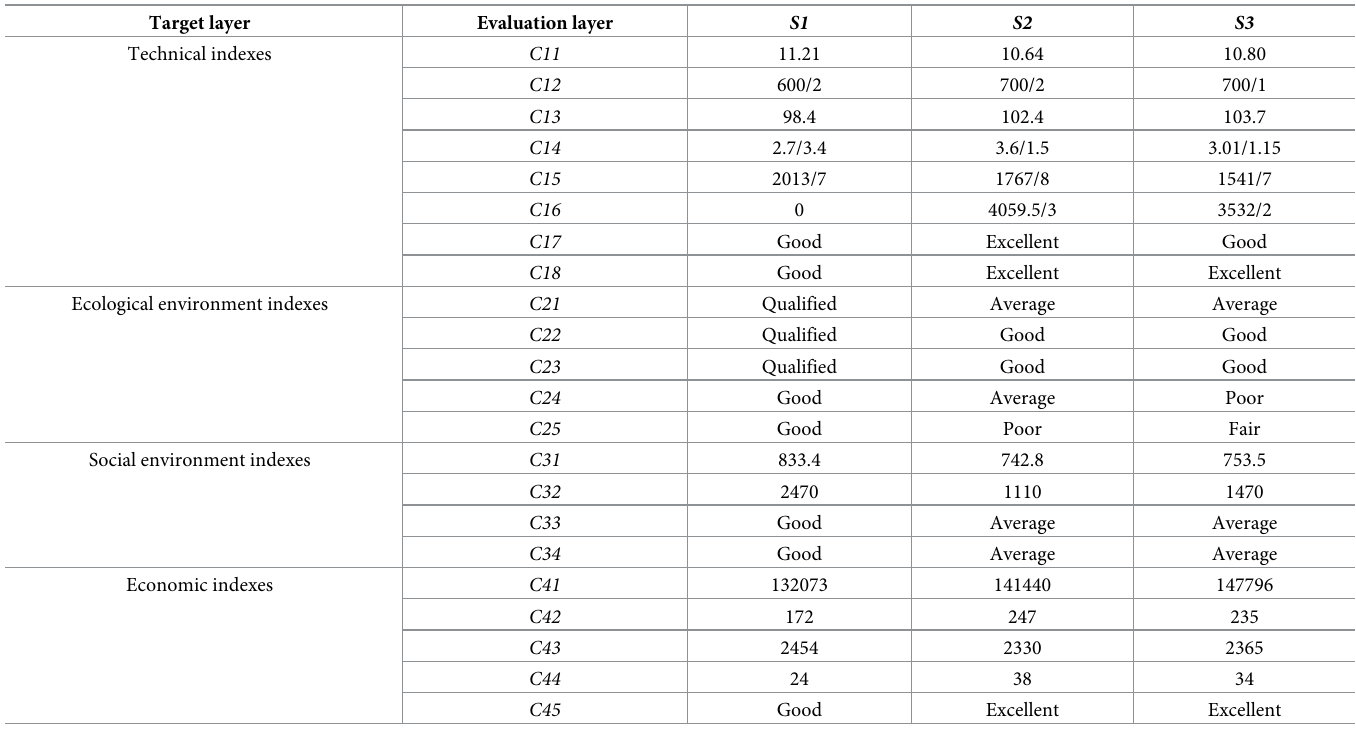
Table 3. Evaluation indexes for the